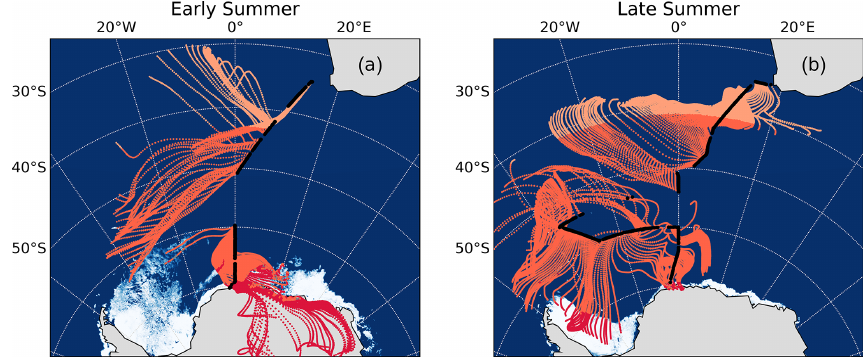
Figure 5. The 72h AMBTs computed for each hour of the voyage during early (a) and late (b) summer, when the HV-AS was operational for more than 45min of the hour. Light orange, dark orange and red AMBTs represent time spent over the low-, mid- and high-latitude Southern Ocean, respectively. The white area represents the location of the sea ice (see Fig. 2